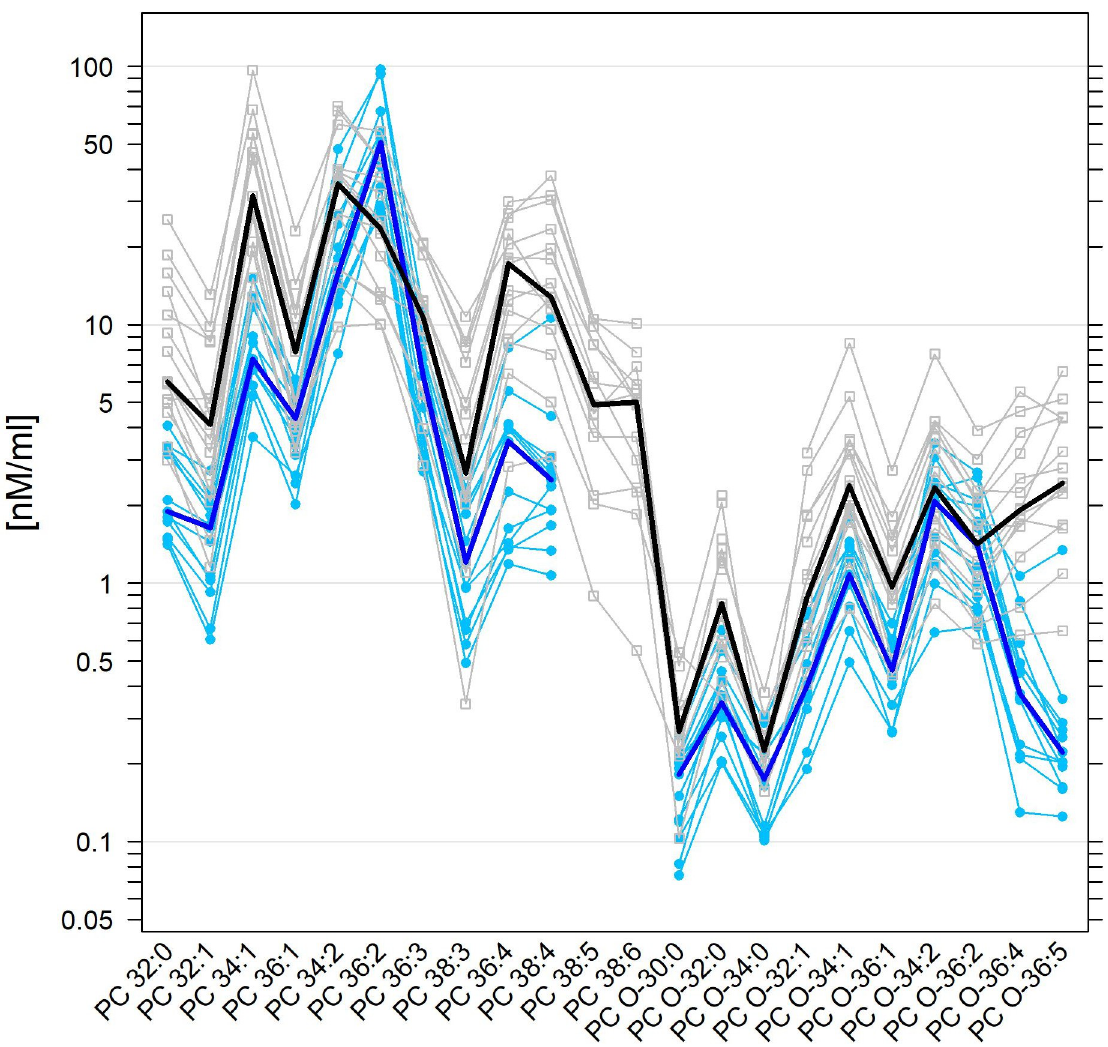
Fig 2. Superposed parallel plots for normal human and equine SF levels of PC (O) species. The univariate scatterplots of PC (O) species concentrations in SF (human: Grey open squares; equine: Light blue filled circles) are juxtaposed parallel to each other, here on a log 10 - transformed scale. Lipid concentration values from the same individual are linked by a polyline (colour-coded according to human or equine group membership) thus forming a ‘profile’ for each individual. Some lipid concentration values are missing due to their levels being below 1% of the total PC (O) class, which interrupt the profile. Median values of lipid species concentrations in SF across individuals in each group are presented as superposed, thicker profiles (human: Black; equine: Dark blue) resulting in group-specific ‘median